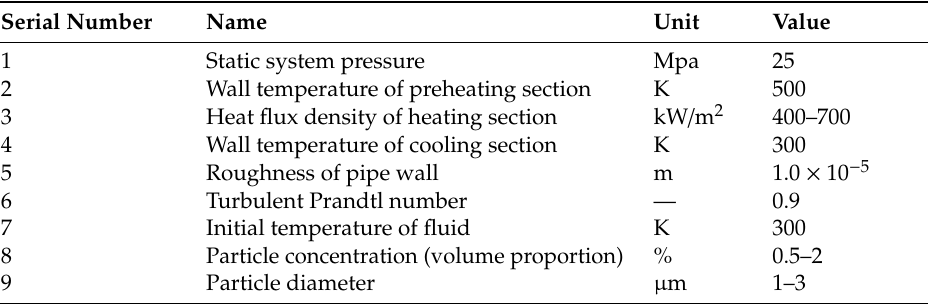
Table 1. Boundary Condition Parameter